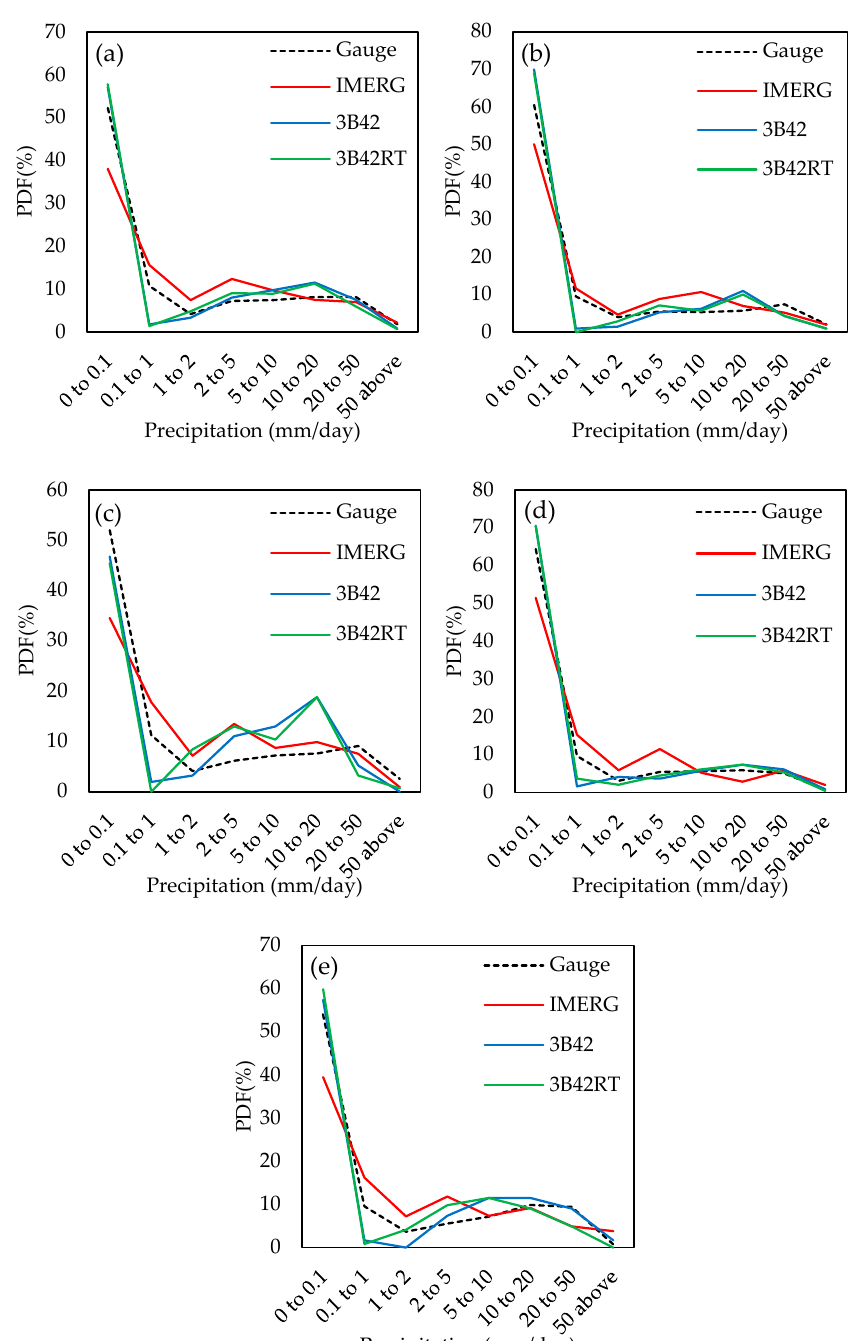
Figure 5. Probability Density Function (PDF) of daily precipitation in ( a ) entire, ( b ) NEM, ( c ) IM1, ( d ) SWM and ( e ) IM2 time